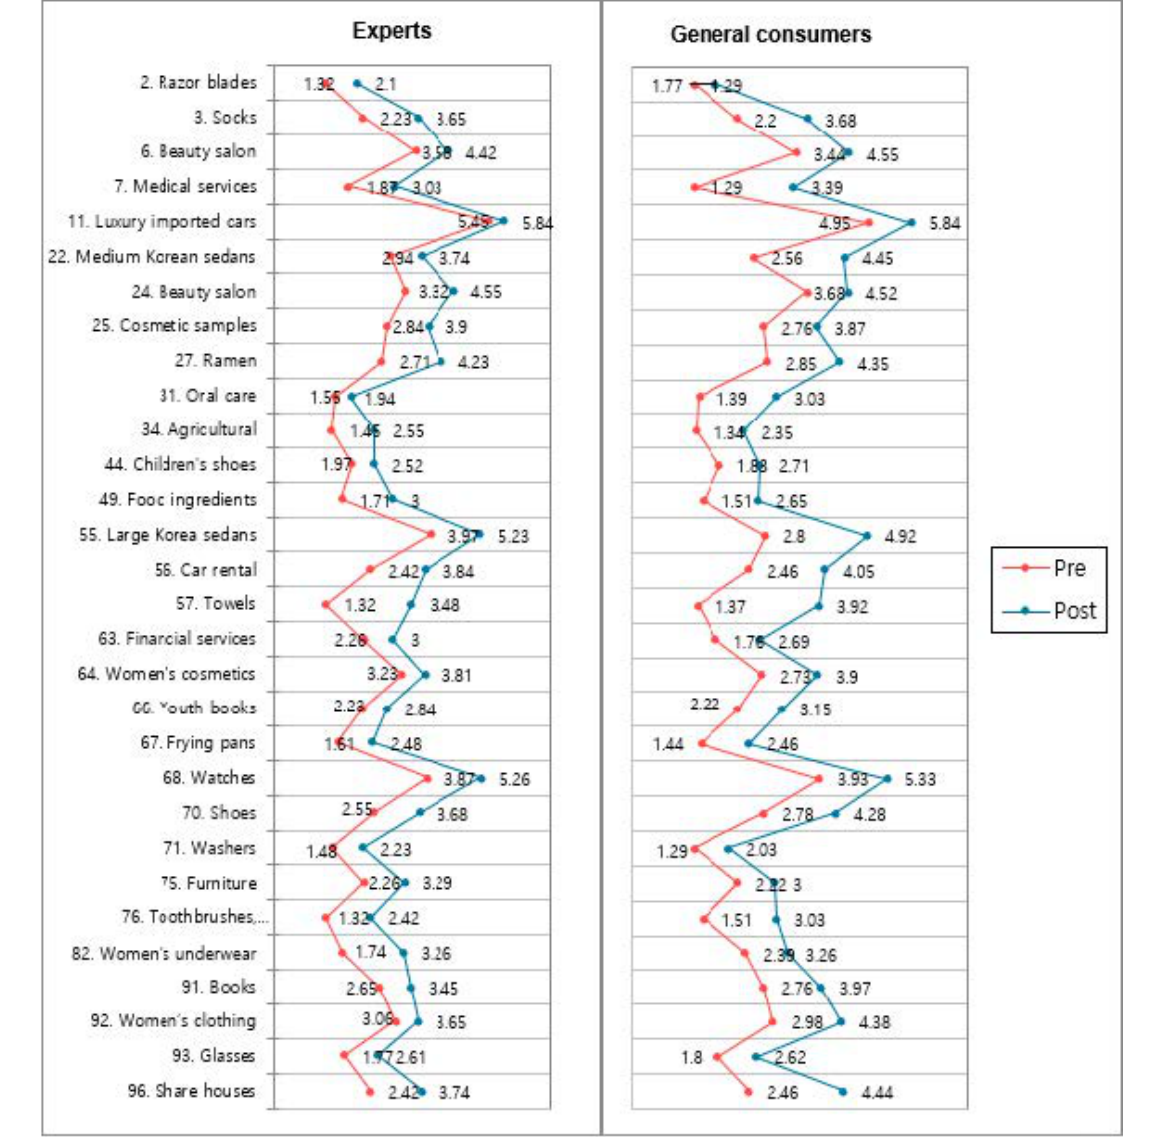
Figure 3. Items with significant t -test results in both experimental designs: consumption motivation.